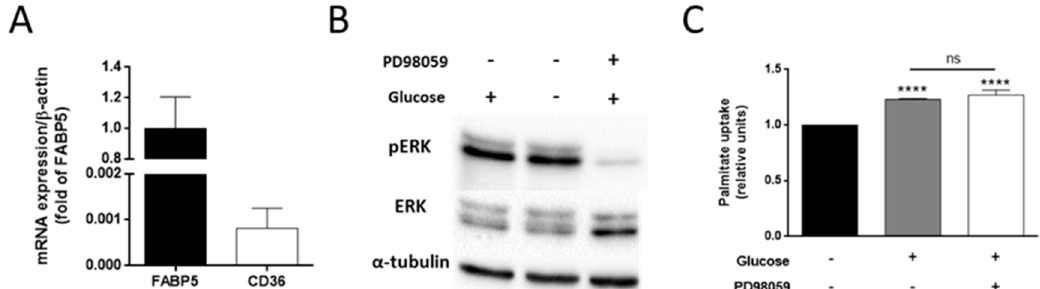
Figure 5. Effect of glucose on the ERK (Extracellular signal-Regulated Kinases) signaling pathway in MDA-MB-231 cells. ( A ) mRNA expression of FABP5 and CD36 transporters. ( B ) ERK phosphorylation and ( C ) palmitate uptake in the presence of 5 mM glucose alone or along with 30 µ M of PD98059. ( B , C ) were performed after 30 min of fasting and 30 min of incubation with 0.5 mM palmitate and 2 µ M BODIPY (BOron-DIPYrromethene) FL C 16 . Data are expressed as means ± SD of three independent experiments. **** p < 0.0001 versus condition without glucose and PD98059.